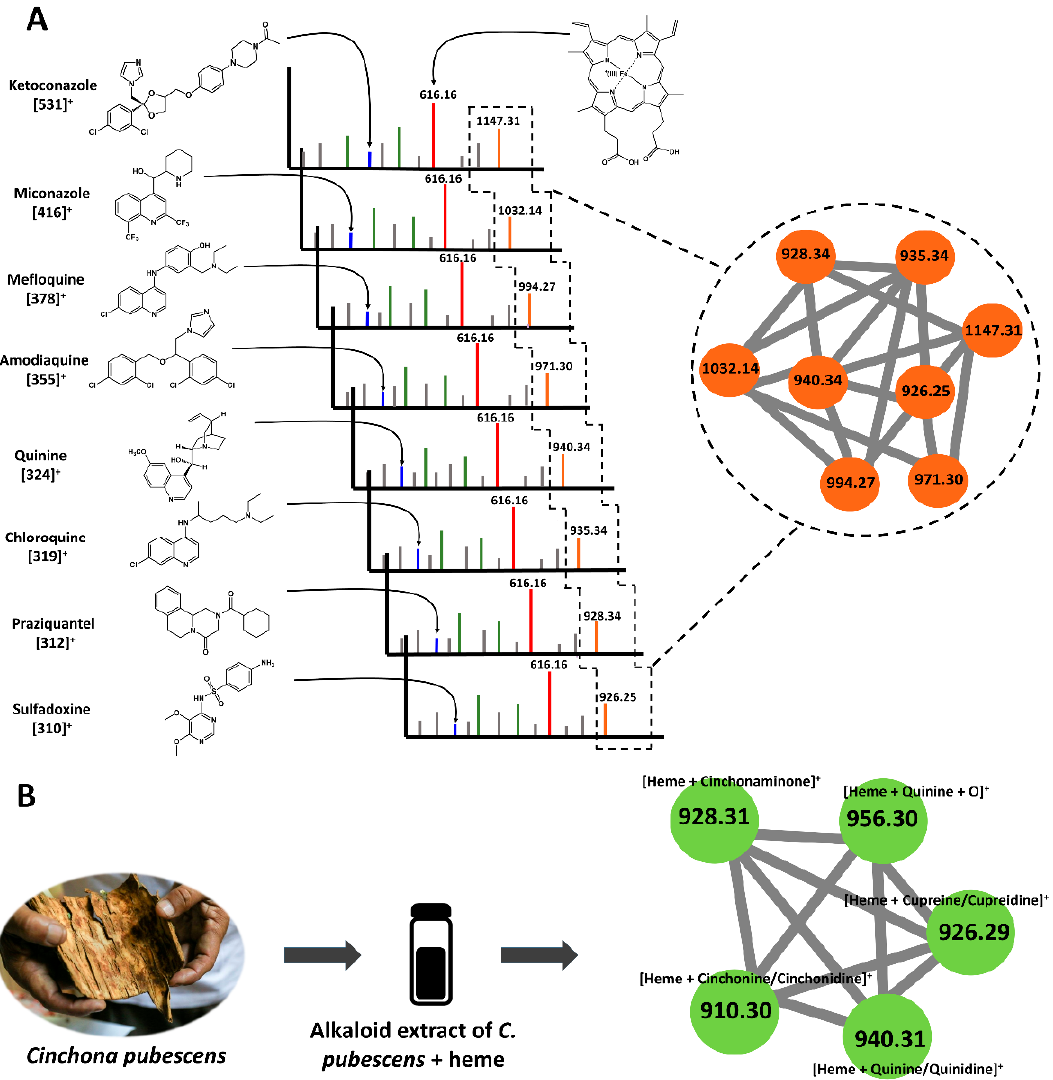
Figure 2. Validation of the biodereplication workflow. ( A ) Visualization by MS and molecular network of heme adducts for a set of antimalarial drugs. Spectrum of each drug–heme mixture displayed the m / z of drug [M+H] + , heme [616] + , and drug–heme adduct [drug + heme] + . Additionally, MN for all drugs is shown in the same cluster. ( B ) Visualization by MS and molecular network of heme adducts in an alkaloid extract from C. pubescens .